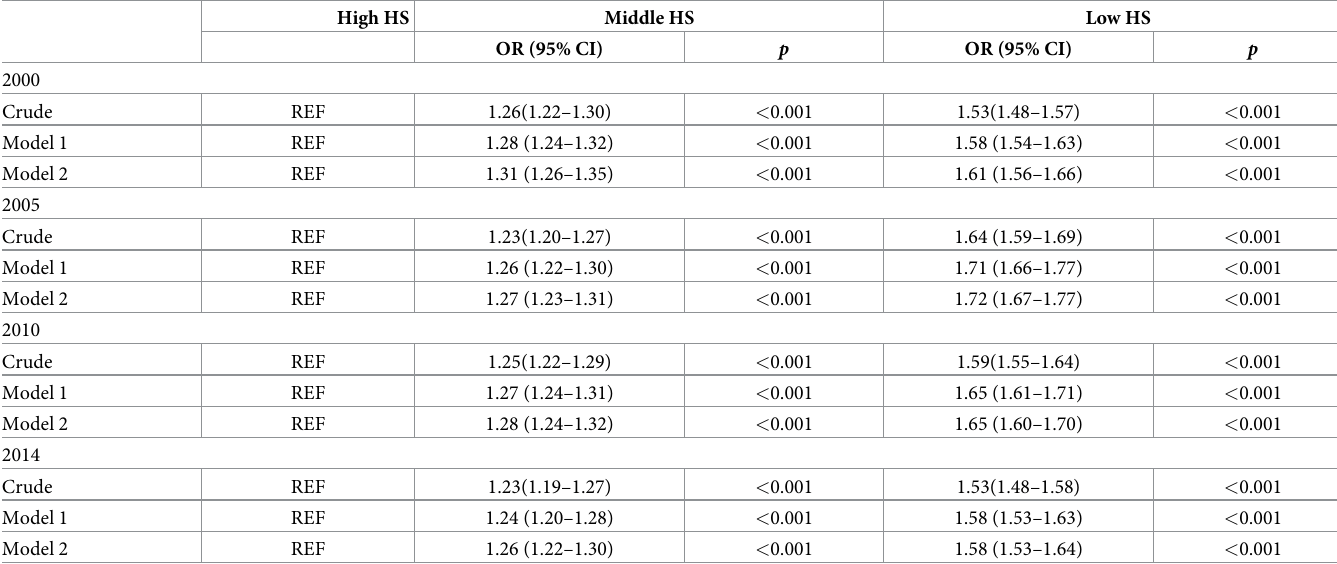
Table 2. The associations between relative HS (category variable) and